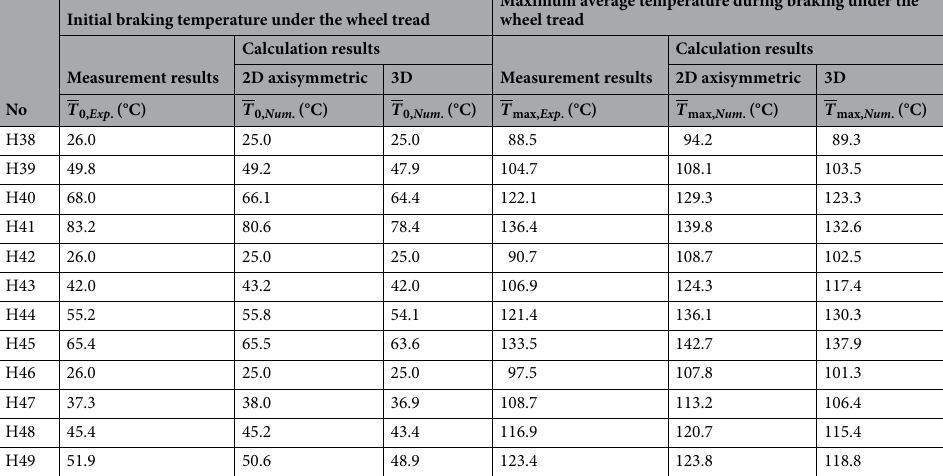
Table 8. Summary of the results of numerical calculations and experimental data: the initial braking temperature and the maximum average temperature during braking under the wheel tread (Material A).